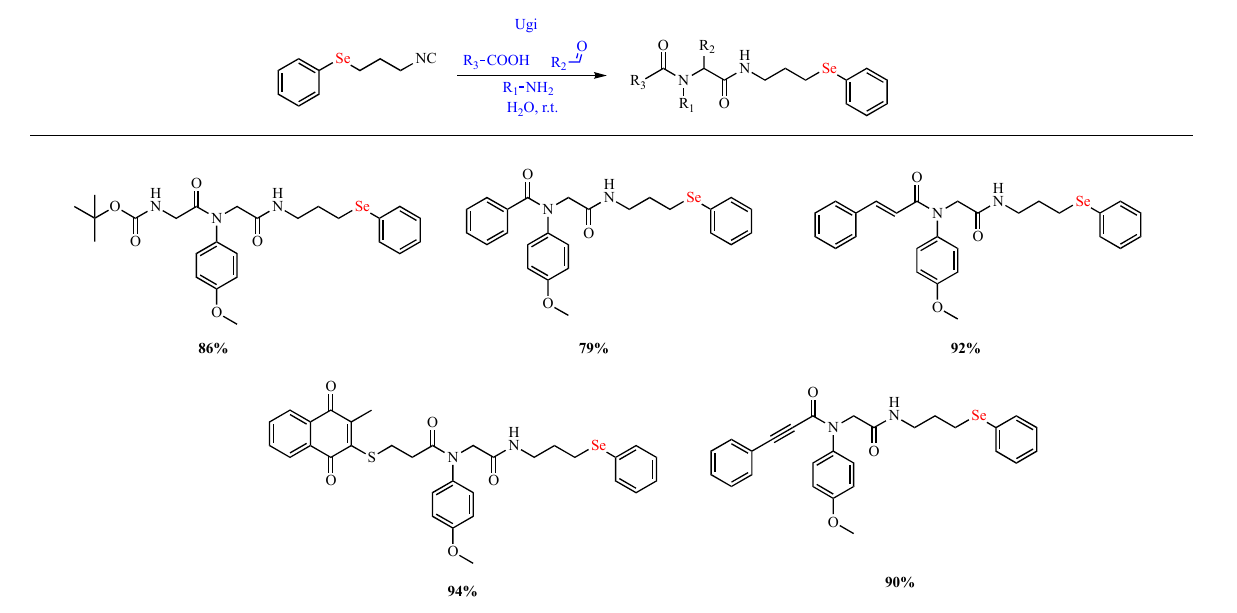
Scheme 37. Synthesis of different Se peptidomimetic compounds.